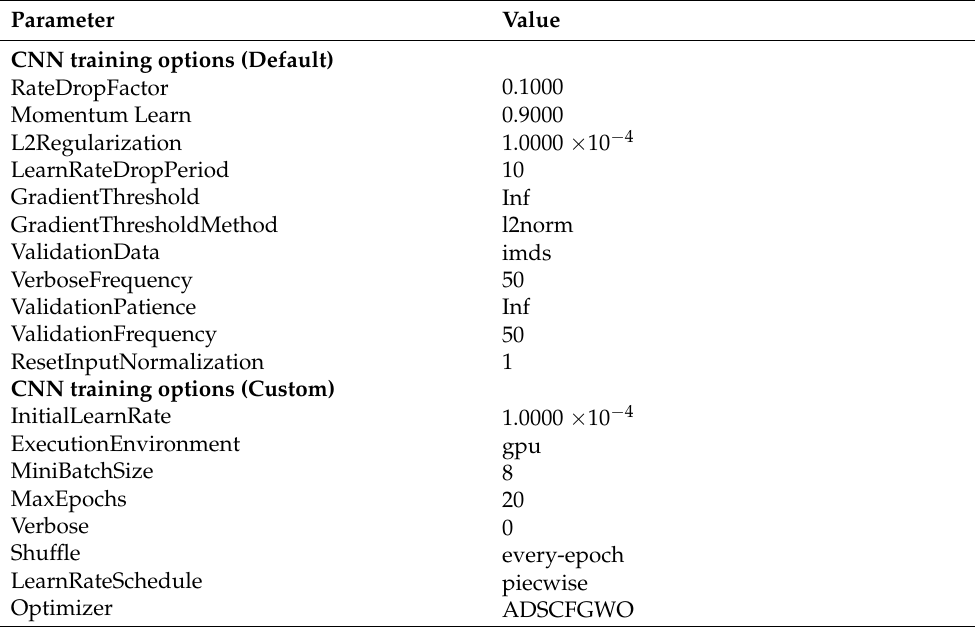
Table 2. CNN hyperparameters